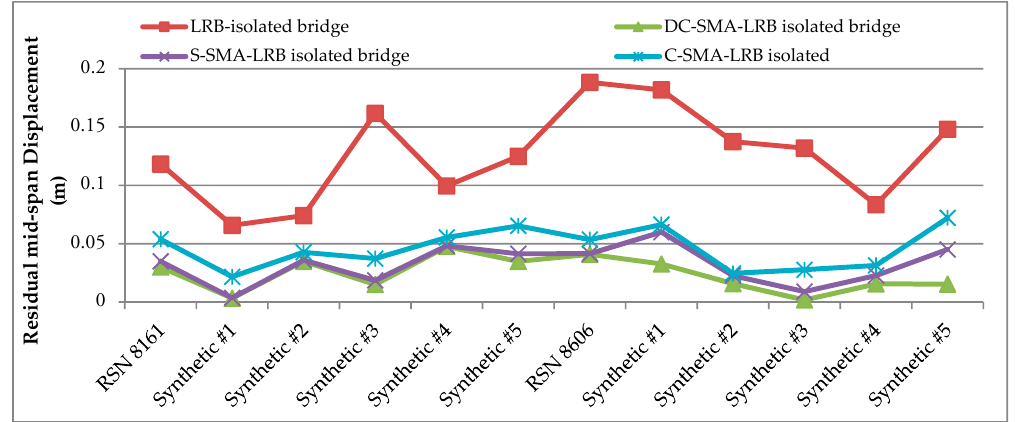
Figure 18. Graphical demonstration of the mid-span residual displacement for the LRB-isolated and three SMA-LRB isolated bridges.